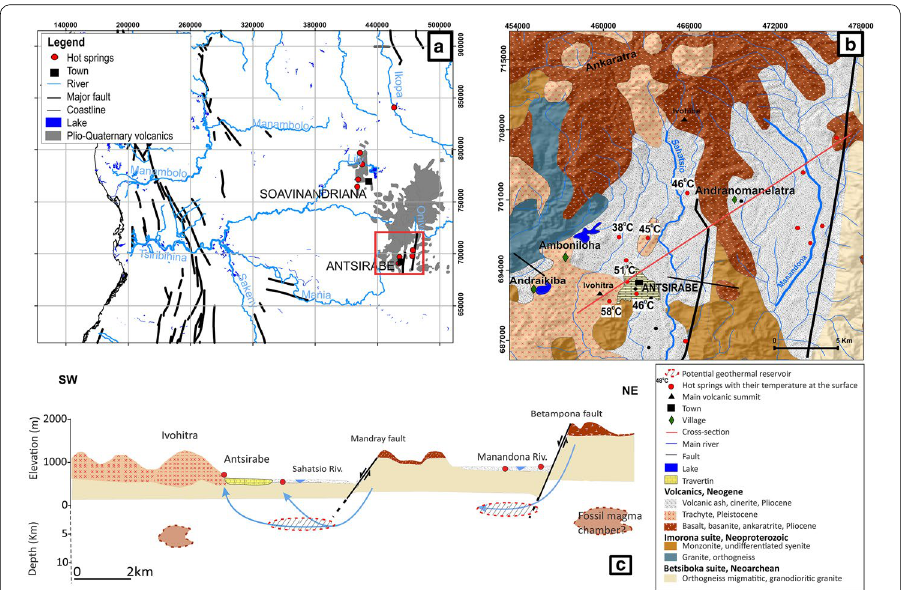
Fig. 5 a Location of the Antsirabe geothermal area, b detailed geology showing the position of the hot springs, modified from Rufer (2009), and c conceptual model of the Antsirabe Basin geothermal system, adapted from Rasoanimanana et al. (2012). The vertical scale of the elevation profile, which was created using ASTER imagery, has been exaggerated compared to the depth scale, which is based on the structure of the crust and uppermost mantle beneath Madagascar (Andriampenomanana et al.